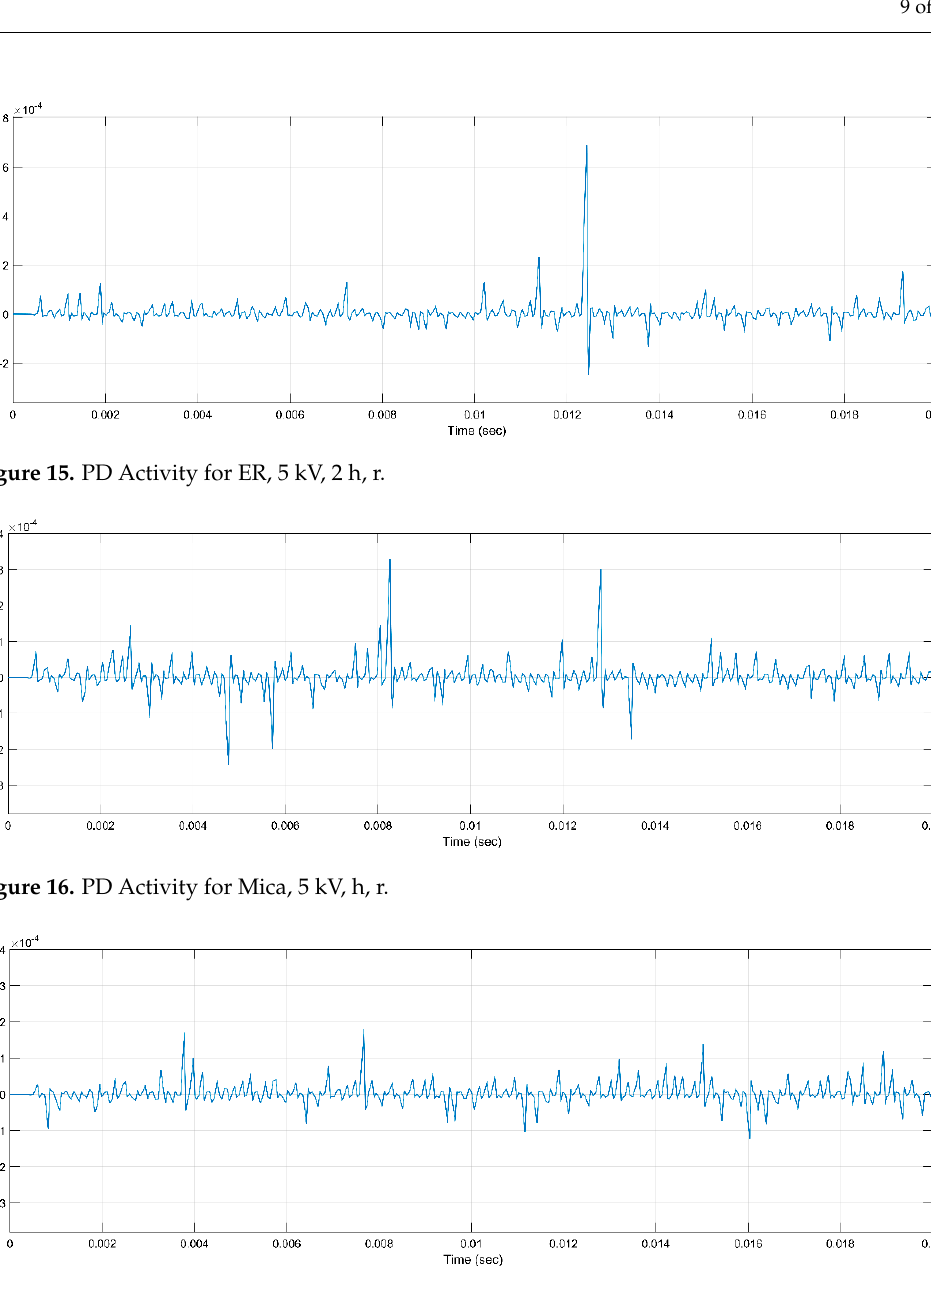
Figure 17. PD Activity for Mica, 10 kV, h, r.